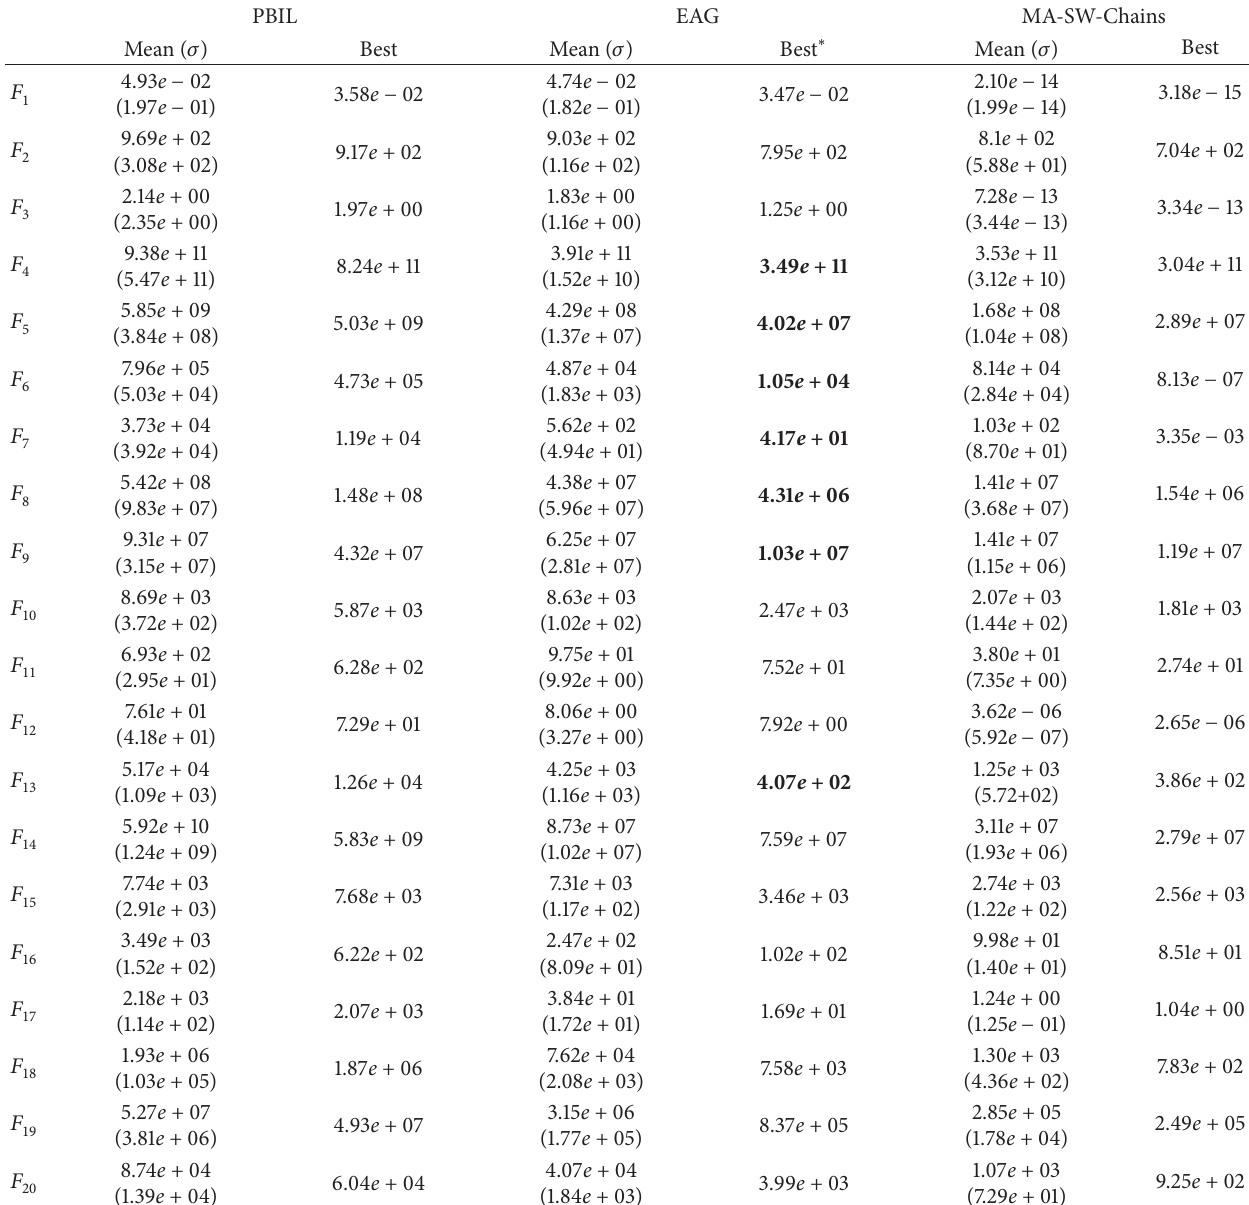
Table 2: The solution quality of PBIL and EAG on CEC’2010 benchmark functions.